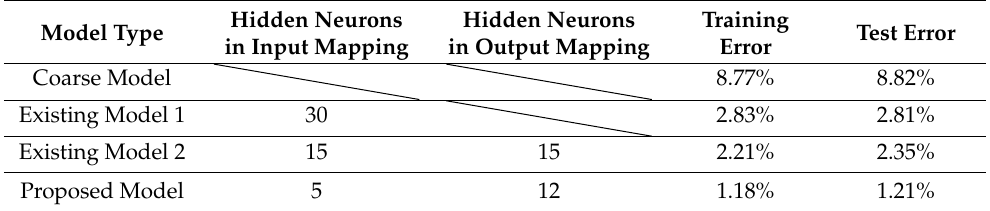
Table 1. Modeling results of four modeling methods.